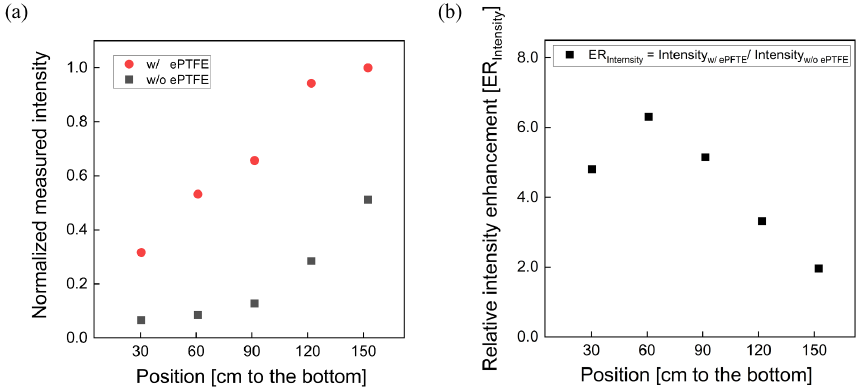
Figure 4. Relative UV intensity profile (a) and intensity enhancement (b) achieved when the flow tube was wrapped with a reflective ePTFE gasket.